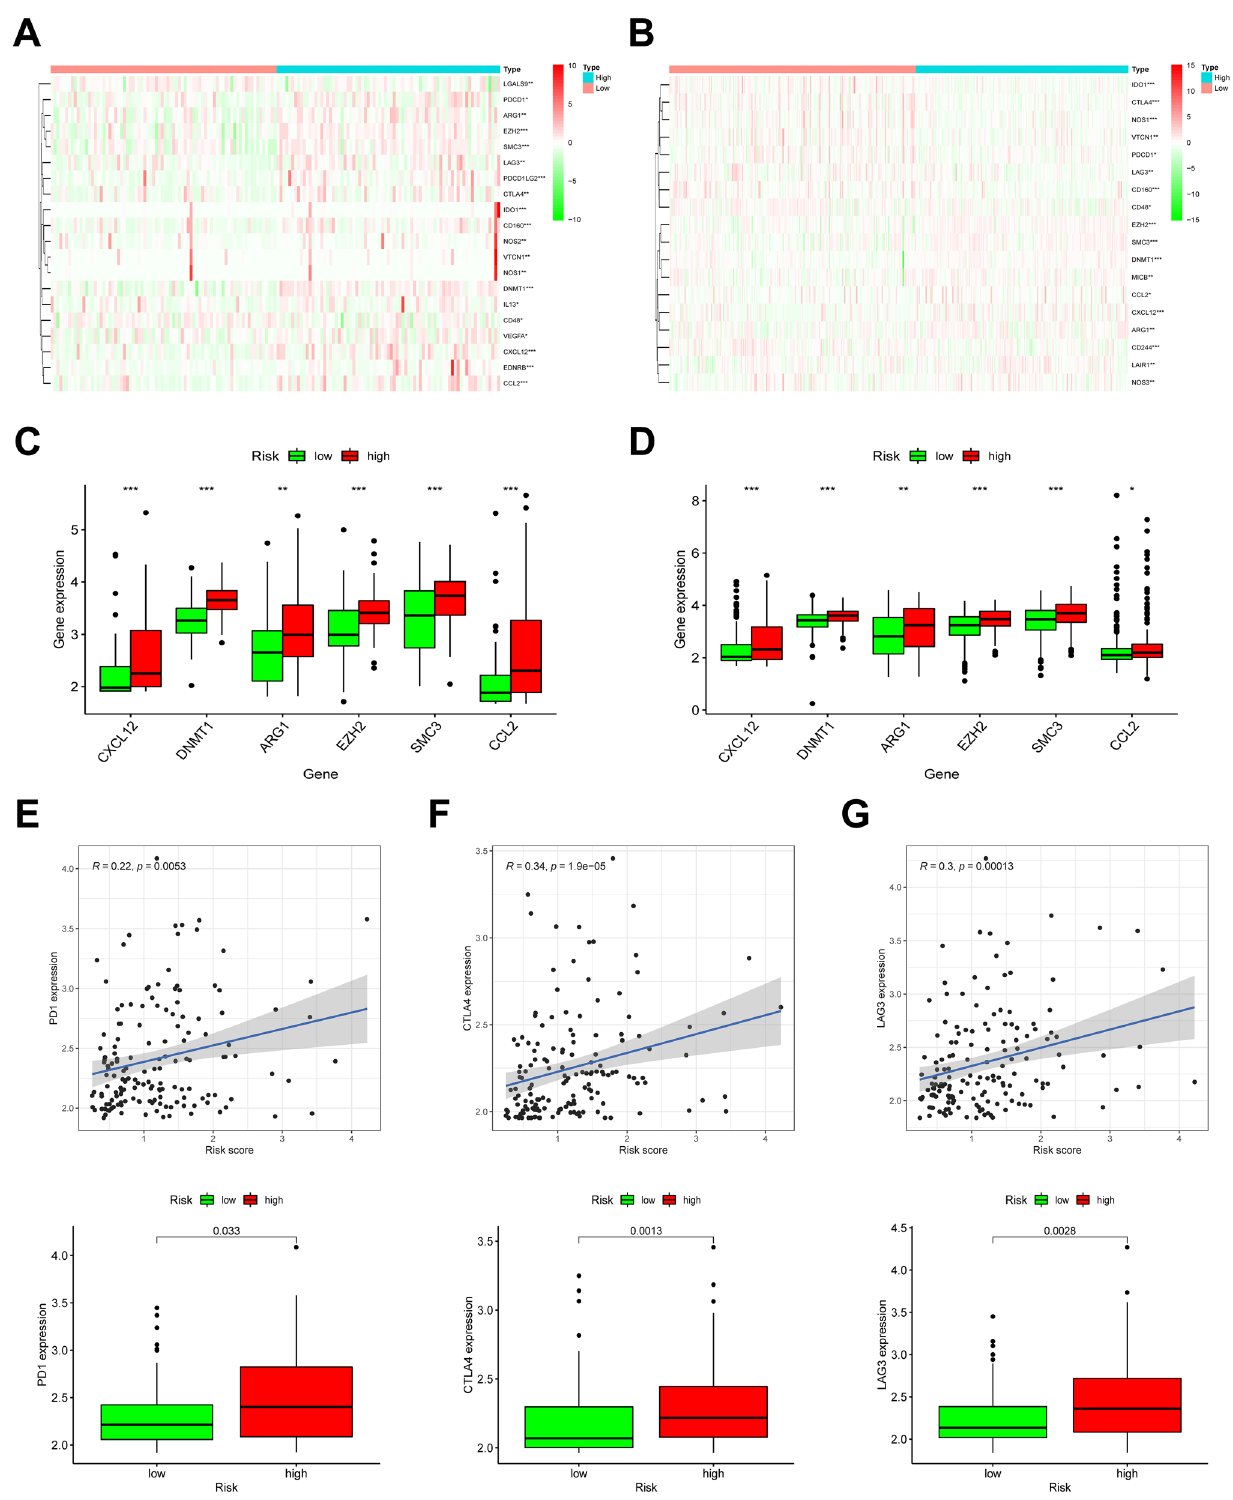
Figure 7. Formation of immunosuppressive microenvironment in high hypoxia risk group. ( A , B ) Heatmaps of the expression profiles of genes which negatively regulated the Cancer-Immunity Cycle in TARGET (https:// ocg. cancer. gov/ progr ams/ target) and GEO (https:// www. ncbi. nlm. nih. gov/ geo); ( C , D ) The expression levels of immunosuppressive cytokines in two hypoxia risk groups; * P < 0.05, ** P < 0.01 and *** P < 0.001; ( E – G ) Correlation between expressions of three immune checkpoints (PD1, CTLA-4, and LAG3) and hypoxia risk score, and their expressions in two hypoxia risk groups of AML